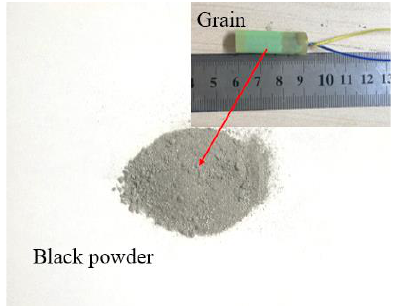
Figure 3. Preparation of explosives.